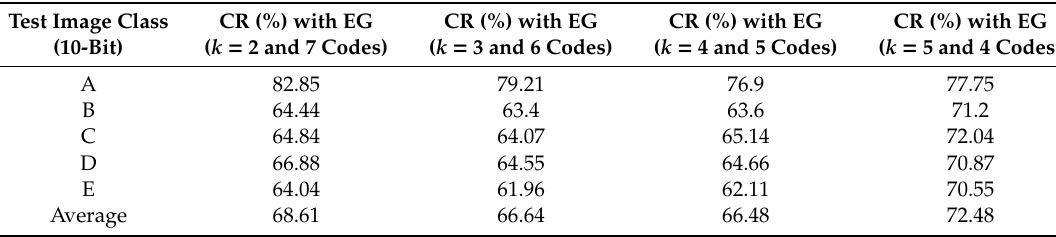
Table 10. CR comparison with EG with di ff erent codewords for 10-bit